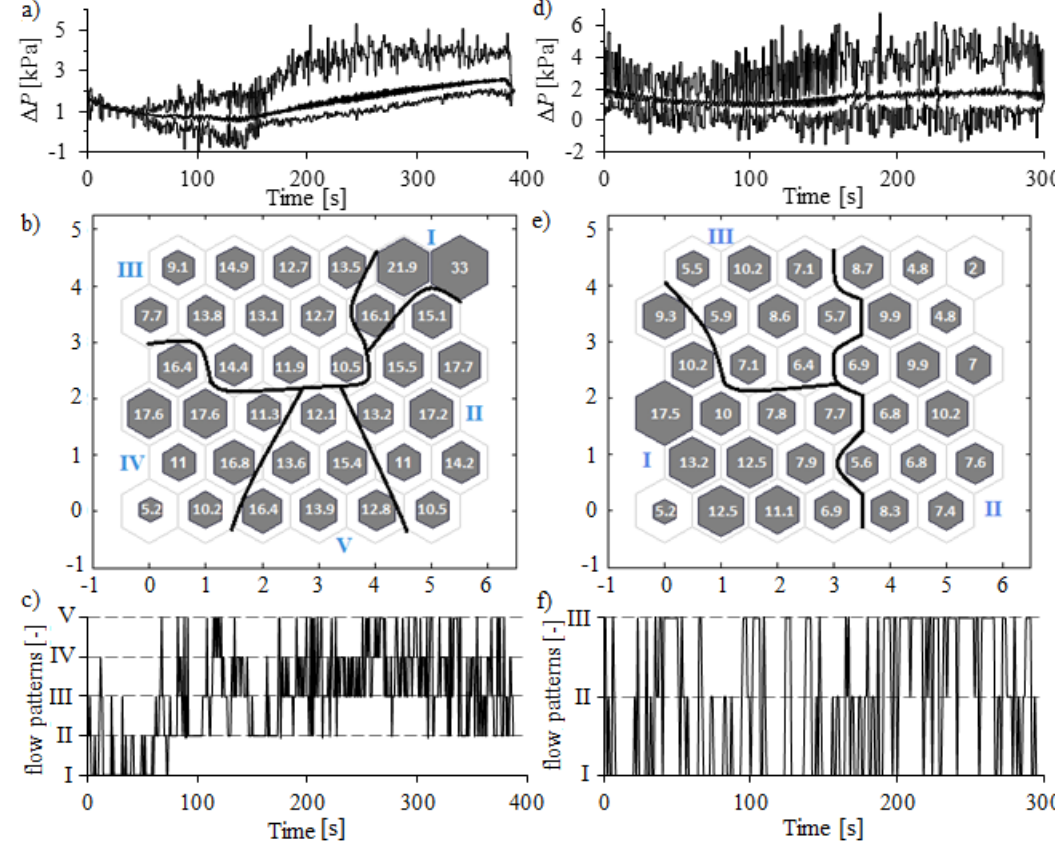
Figure 9. Results of SOM analysis for two-channel heat exchangers at G = 61.65 kg/m 2 s and P = 75.6 W: ( a ) the maximum, minimum, and average values of the pressure drop oscillations; ( b ) the average hit histogram of 10 results of SOM obtained from the RQA of pressure drop time series; ( c ) boiling flow pattern oscillations and heat exchangers at G = 38.8 kg/m 2 s and 55.8 W: ( d ) the maximum, minimum and average values of the pressure drop oscillations; ( e ) the average hit histogram of 10 results of SOM obtained from the RQA of the pressure drop time series; ( f ) boiling flow pattern oscillations.